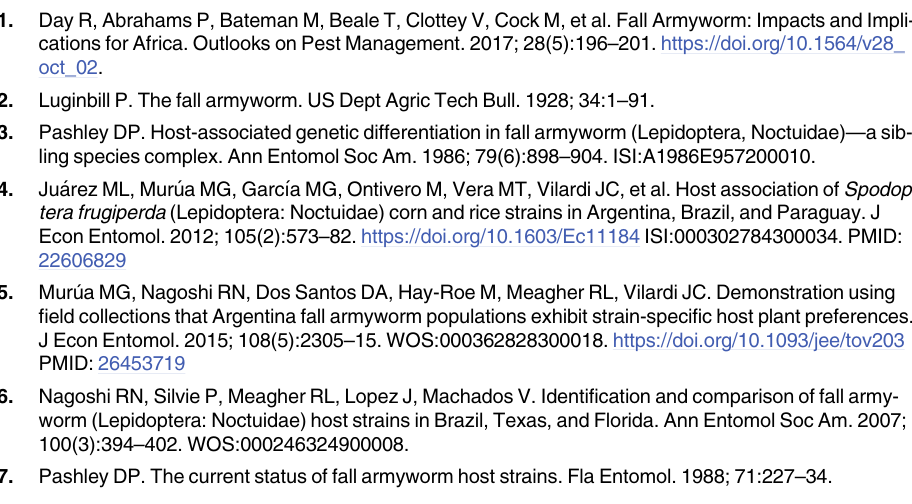
S1 Table. Source information for fall armyworm specimens used in this study and reported in submitted